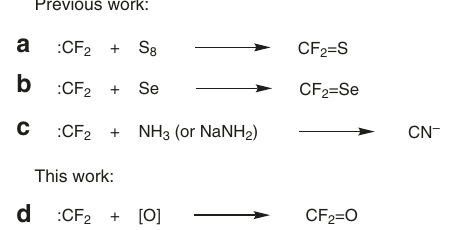
Fig. 1 The transformations of di fl uorocarbene. a The transformation of di fl uorocarbene into thiocarbonyl fl uoride. b The transformation of di fl uorocarbene into selenocarbonyl fl uoride. c The transformation of di fl uorocarbene into cyanide anion. d The transformation of di fl uorocarbene into carbonyl fl uoride. Table 1 Optimization of tri fl uoromethoxylation